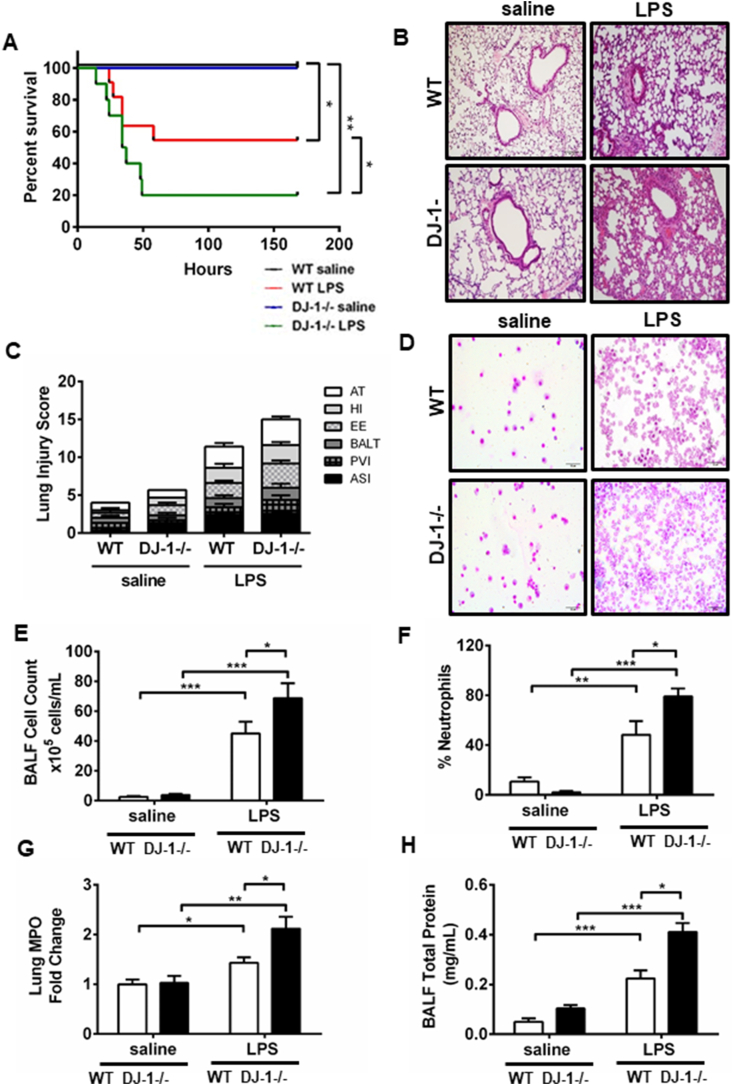
Absence of DJ-1 exacerbates LPS-induced acute lung injury. A) Percent survival of wildtype (WT) and DJ-1−/− mice at 7 days after LPS instillation compared with saline (SAL) controls. (saline n = 5, LPS n = 10–11, *p < 0.05 **p < 0.01, Log-rank/Mantel-Cox analysis) B) Representative H&E stained images of lungs 24 h post-instillation of SAL or LPS. C) Lung Injury Scores (LIS) (n = 3–5 animals) as characterized previously using alveolar septum thickening (AT), hemorrhagic infiltration (HI), exudative edema (EE), bronchus-associated lymphoid tissue aggregates (BALT), perivascular inflammatory infiltrates (PVI), and alveolar septal infiltration (ASI). D) Representative H & E stained images of Bronchoalveolar lavage fluid (BALF) cyto-spins from WT and DJ-1−/− mice exposed to saline or LPS treatment. BALF E) total cell count (n = 8–13), and F) percent neutrophils (n = 8–13) in WT and DJ-1−/− mice at 24 h after saline and LPS treatment. G) Myeloperoxidase levels in lung tissue lysates with saline or LPS treatment (n = 7–14). H) BALF total protein (n = 7–14) at 24 h after saline or LPS treatment. Data are presented as means ± SEM (*p < 0.05, **p < 0.01, ***p < 0.001, two-way ANOVA analysis).